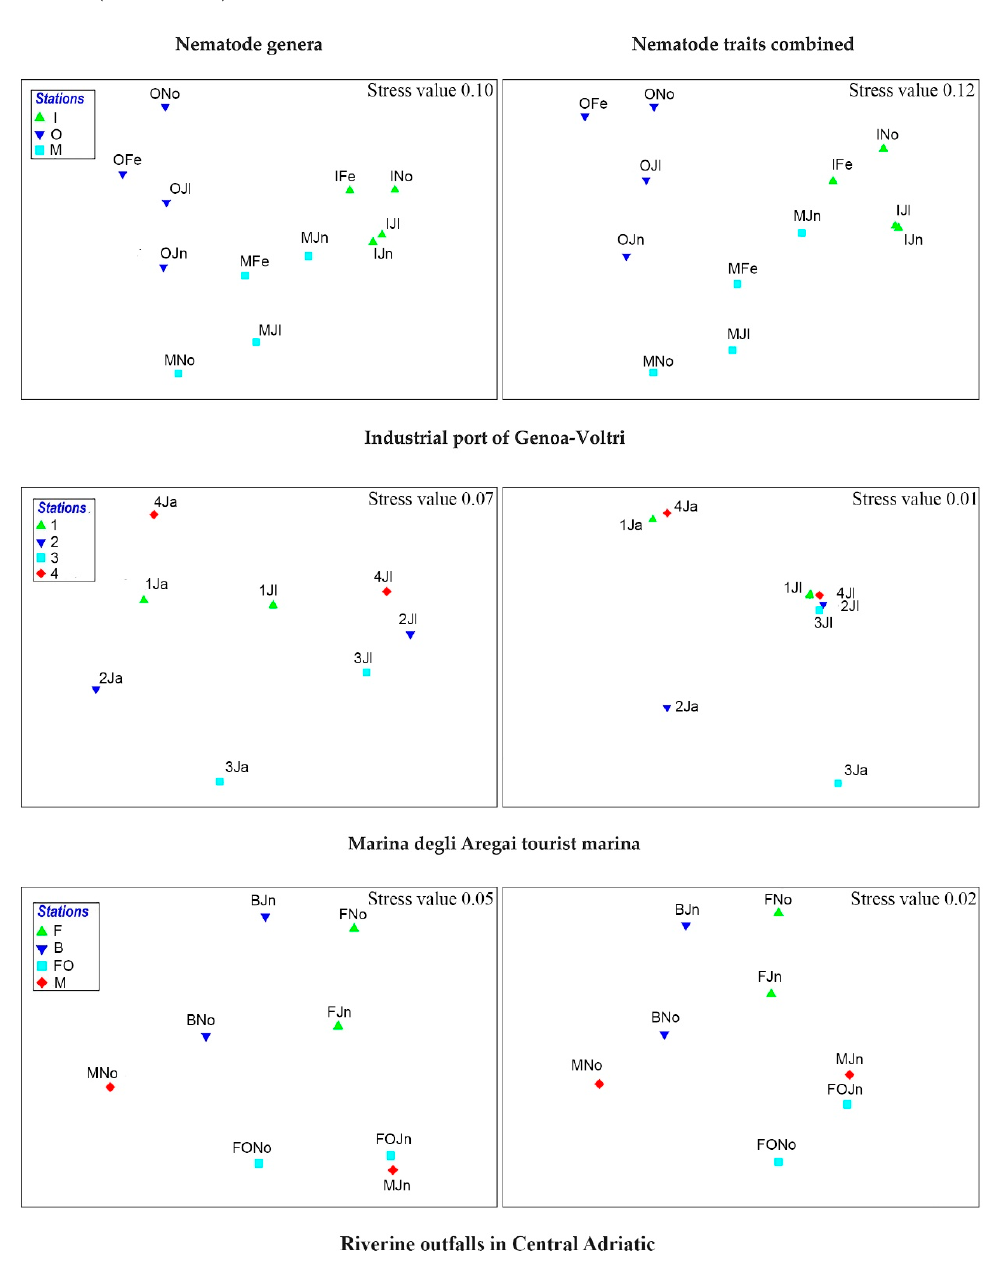
Figure 7. nMDS carried out on untransformed data matrixes of both nematode genera and functional trait codes (Bray–Curtis similarity) from port seabeds (Ligurian Sea) and sediments under riverine outfall pressures (Adriatic Sea) (Ja = January; Fe = February; Jn = June; Jl = July; No = November).